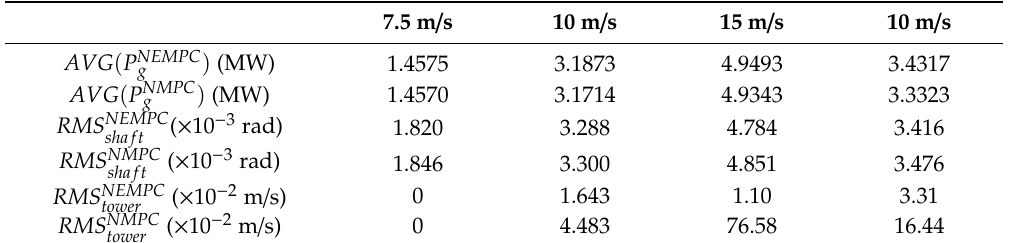
Table 1. Data analysis based on the results in Figure